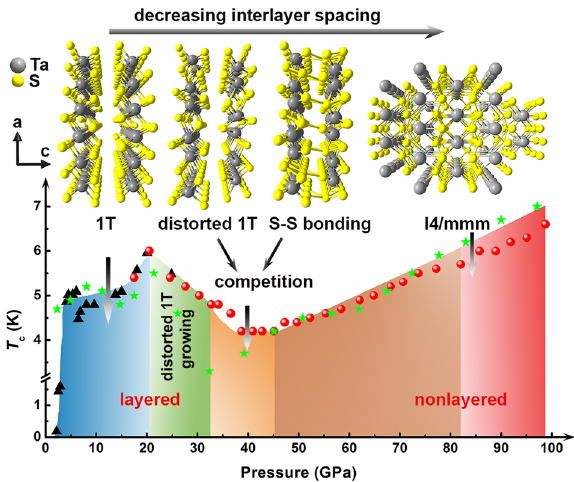
Fig. 4 Schematic diagram of the structural changes in TaS 2 under compression and the T c variation with pressure. The P – T c diagram is divided into different regions based on the structural transitions under high pressure. The black solid triangles represent T c from previous electrical resistivity measurements 20 . The red solid circles and green stars represent the T c measured in run 1 and run 2,